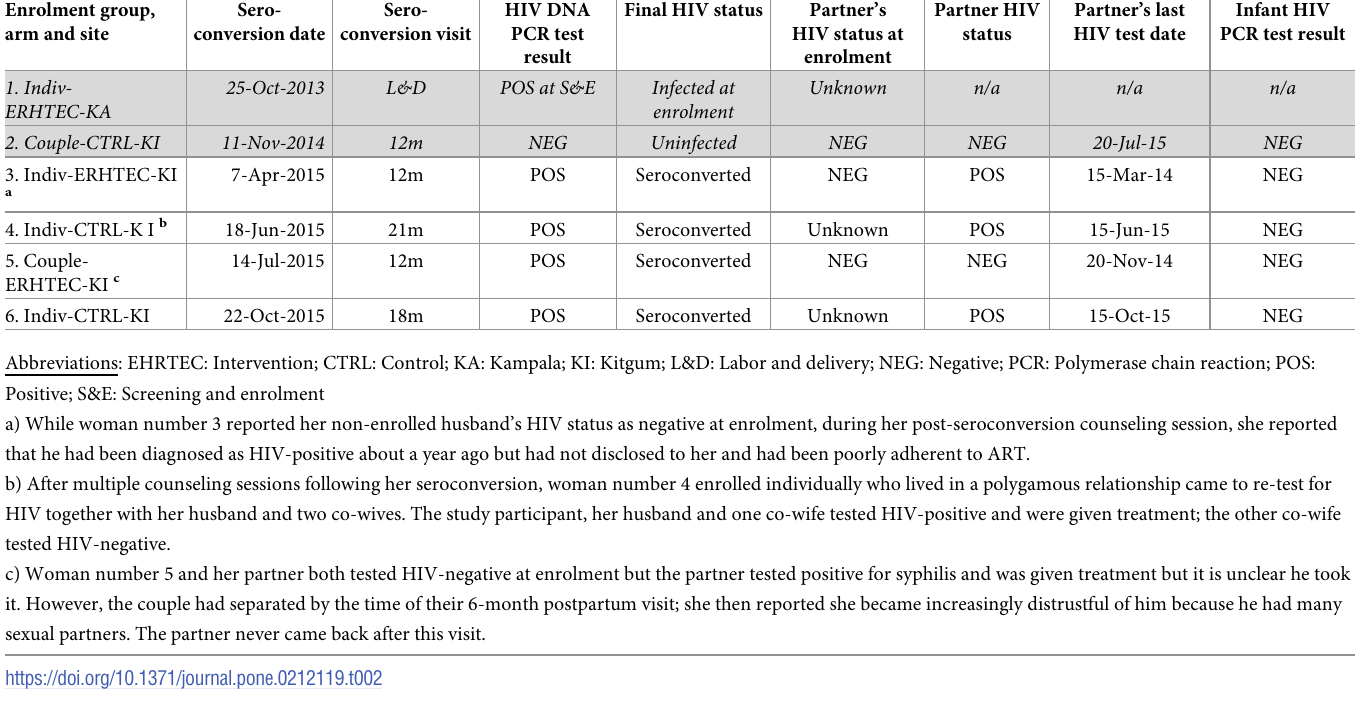
Table 2. Women who seroconverted for HIV during follow-up. Enrolment group, arm and